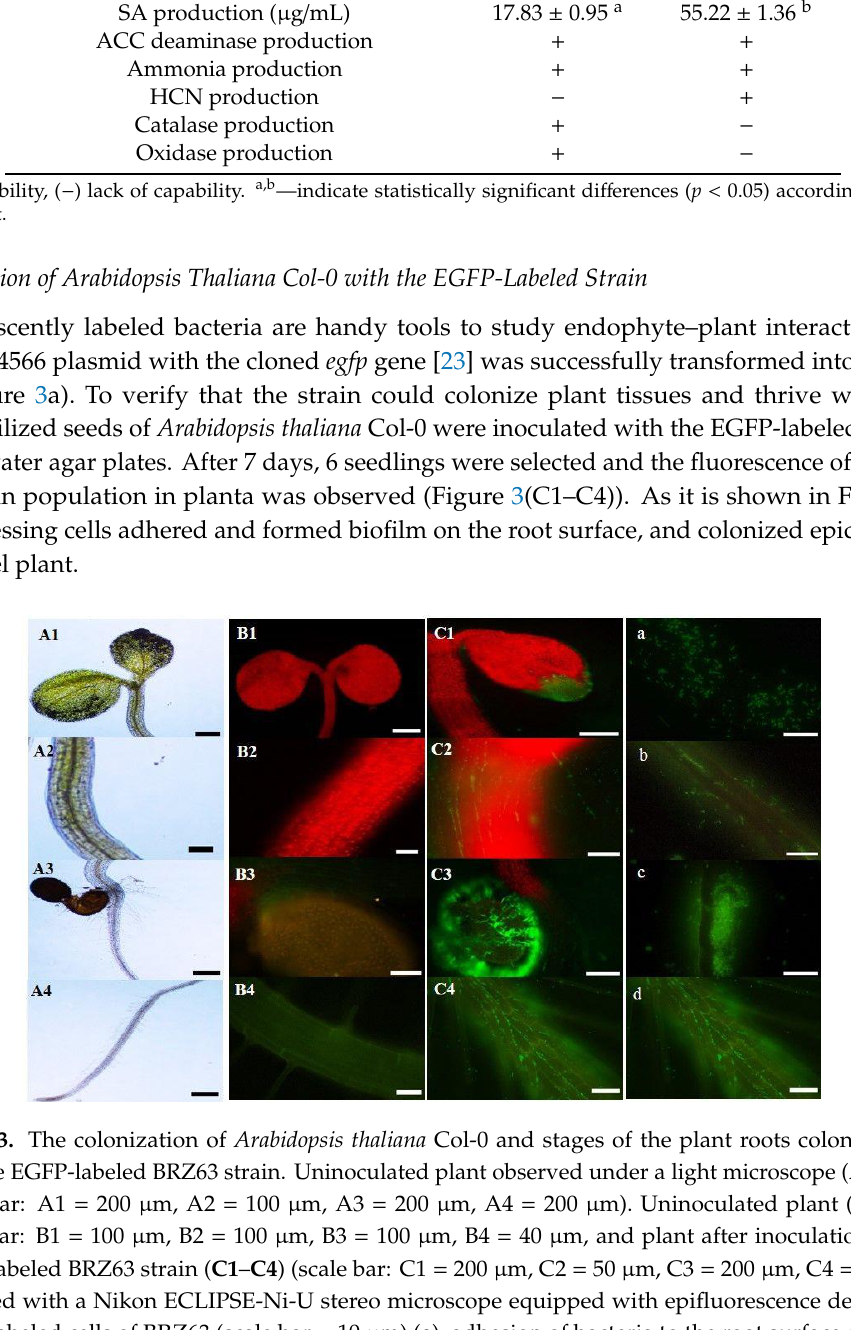
Table 1. Biochemical and physiological characteristics of endophytic P. fluorescens BRZ63. Features